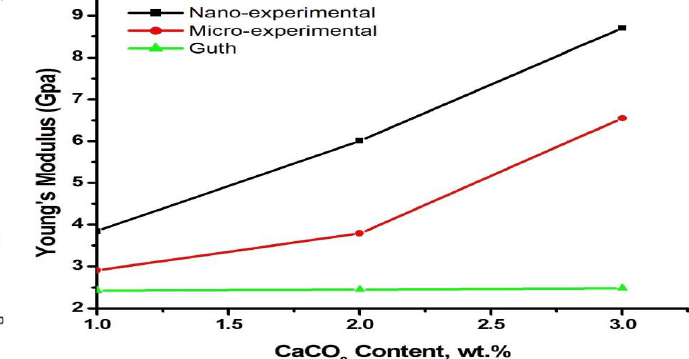
Fig. 9. Variation of elongation of micro and nano-composites with filler loading at break.